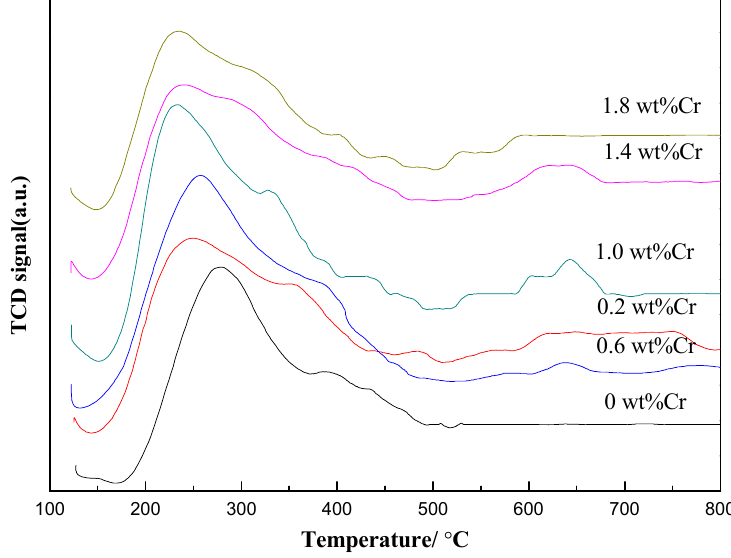
Figure 2. NH 3 -TPD curves of the Cr-Pt/WZ catalyst with different Cr contents.